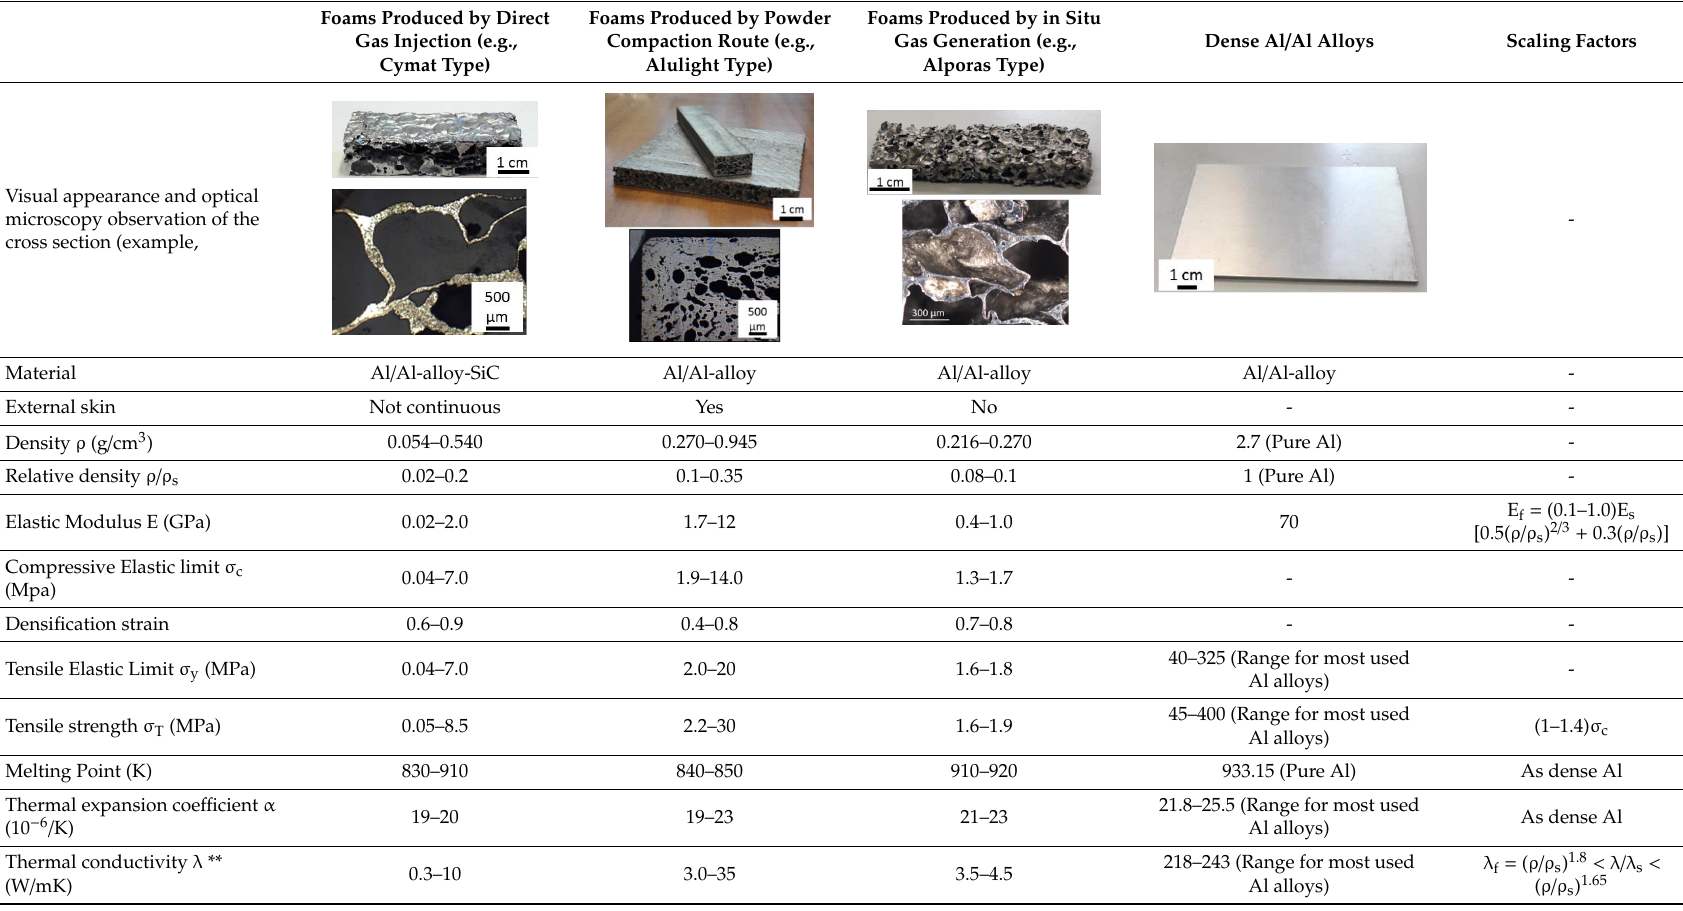
Table 1. Summary of Al-based foams properties compared to dense Al/Al-alloys ones [9,31,36].